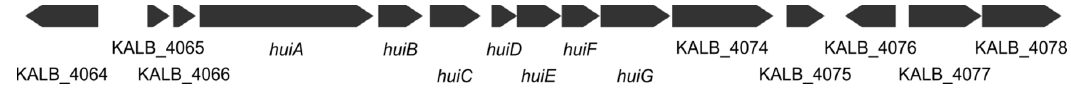
Figure 3. The chromosomal fragment of K. albida containing the huimycin biosynthetic gene cluster. Table 2. Proposed functions of the genes in the DNA fragment containing huimycin gene. Gene Proposed